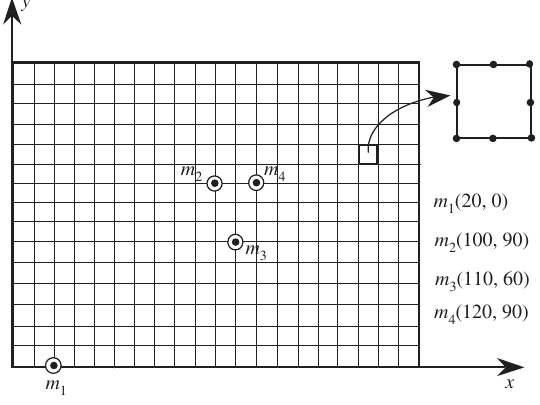
Figure 8: Finite element mesh of rectangular FGM plane structure (measurement locations are indicated by the heavy circle).